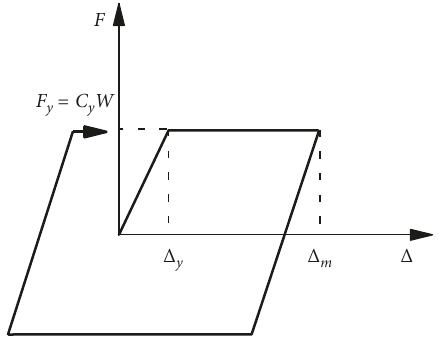
Figure 1: Force-deformation law of an EPP